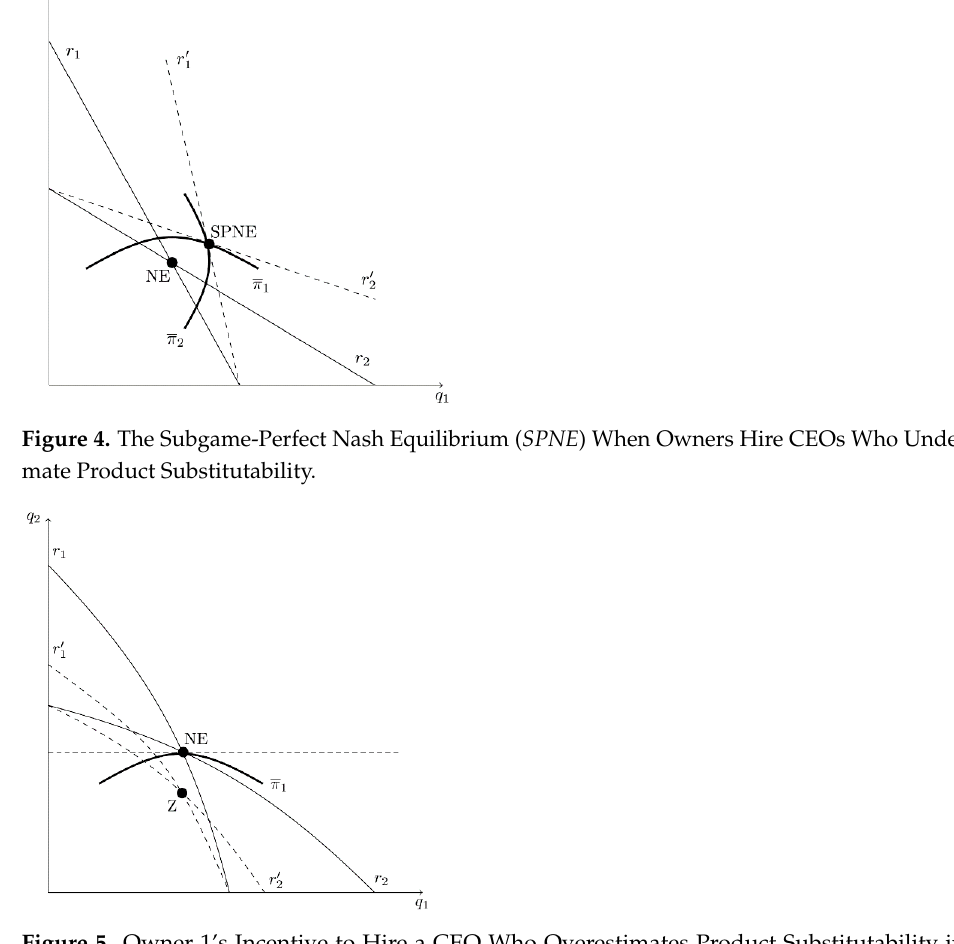
Figure 5. Owner 1 ʹ s Incentive to Hire a CEO Who Overestimates Product Substitutability in the Cournot Model When Overestimation Affects the Best ‐ Reply Curves of Both Firms.